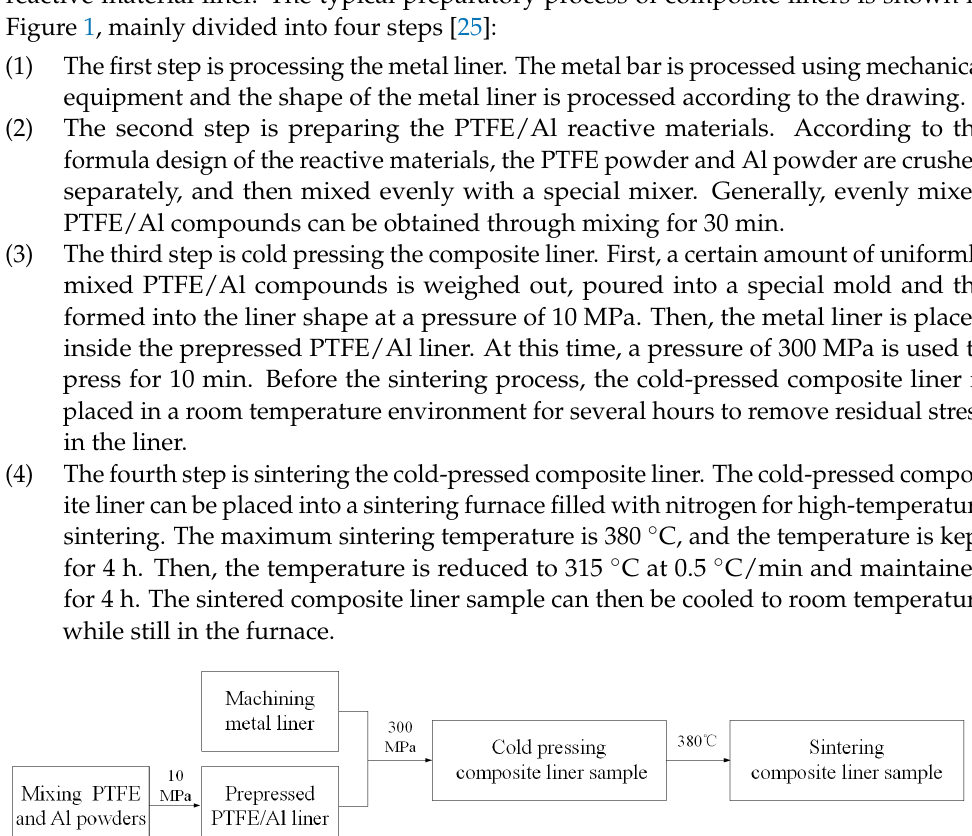
selected to carry out the penetration experiments. The wall thickness of the three types wall thickness of the metal liner t 1 was 1 mm, and the PTFE/Al liner thickness t 2